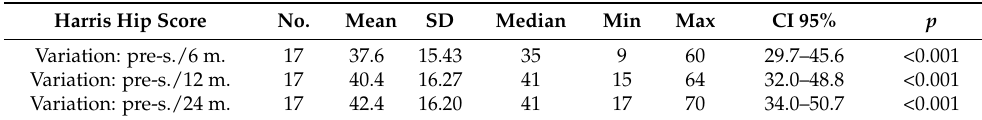
Table 4. Mean HHS values of first revisions in the different follow-up intervals and their comparison with the pre-surgical mean value.